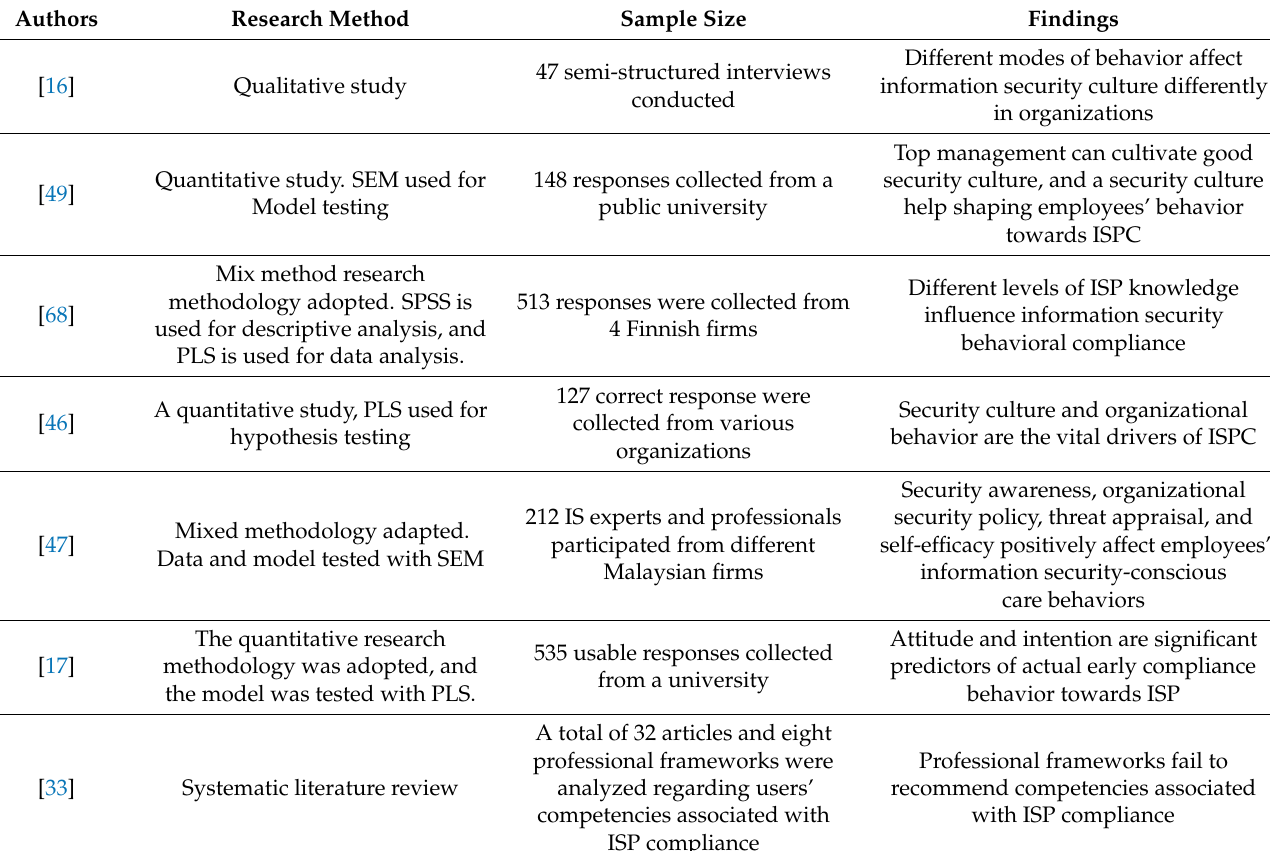
Table 7. Studies on culture/security awareness behaviors and